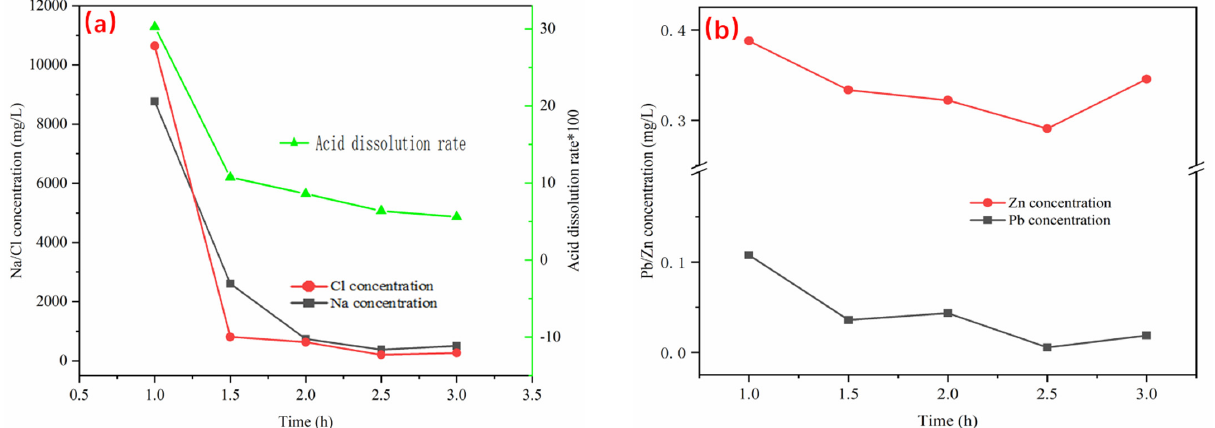
Figure 13. Test results of acid dissolution and water leaching of slag at different smelting times ( a ) acid dissolution ratio and Cl, Na content in water leaching solution; ( b ) Pb and Zn contents in water leaching solution.